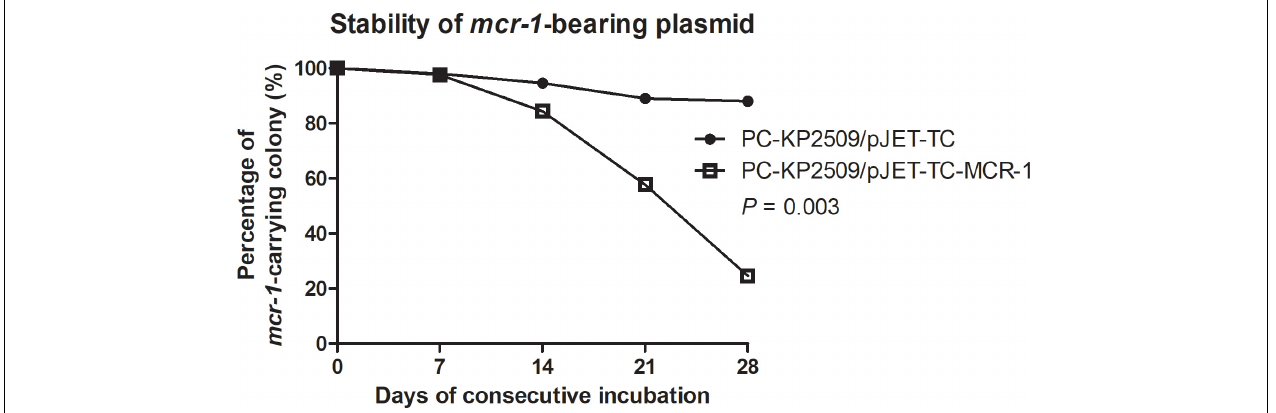
FIGURE 3 | The stability of pJET-TC and pJET-TC-MCR-1 plasmids in PC-KP2509 was compared after consecutive passage. Without antibiotic pressure, pJET-TC-MCR-1 was lost from PC-KP2509 within 7 days (i.e., ∼ 70 generations), and only 24.7% PC-KP2509 population carried the mcr-1 recombinant plasmid on